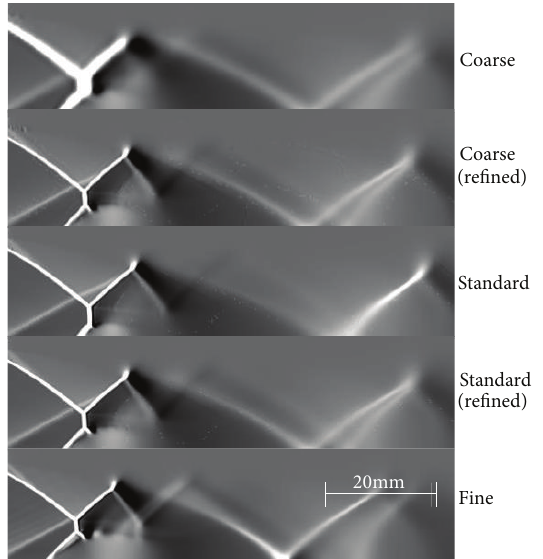
Figure 9: Effect of turbulence model on the predicted shock struc-